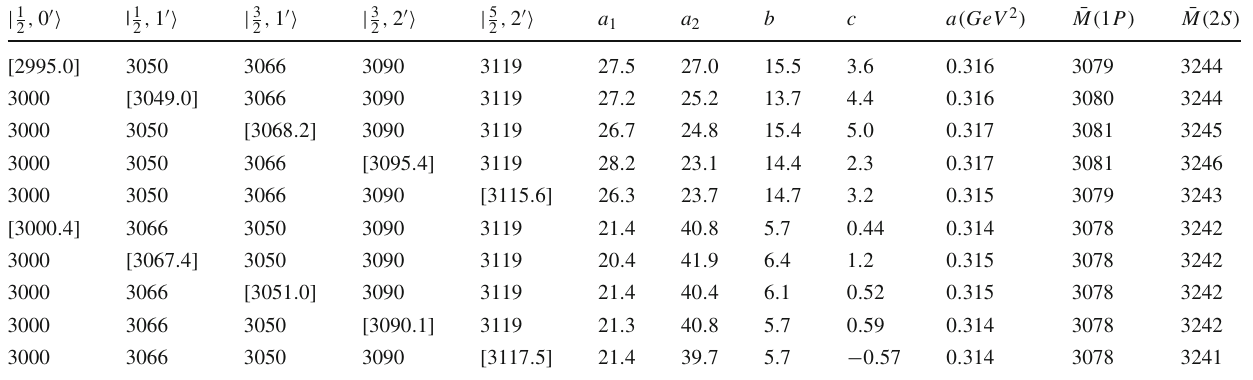
five measured masses are considered. The predicted mass at presum- ably unseen state is marked in square bracket. All parameters except the Regge slope a in MeV